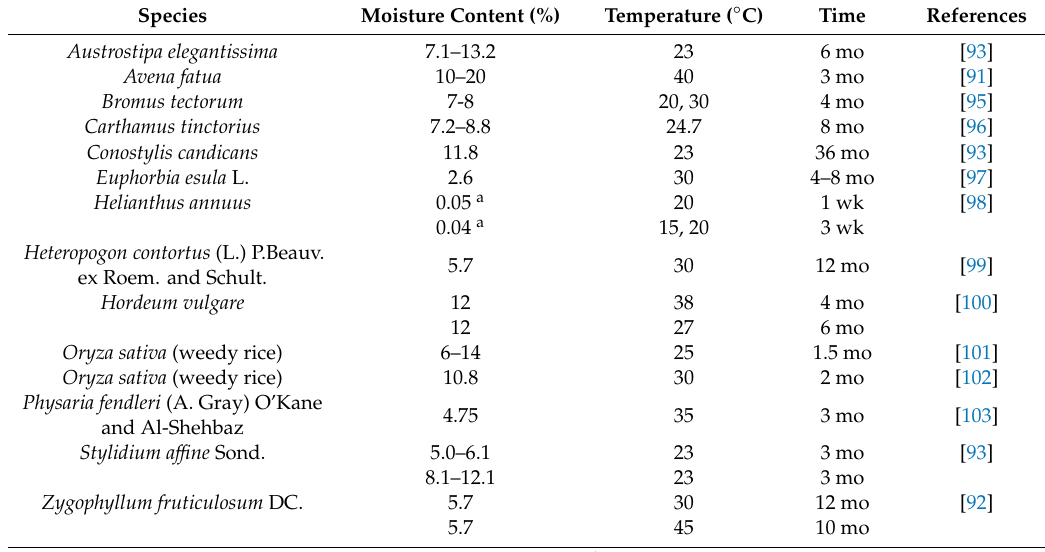
Table 1. The most e ff ective conditions for afterripening of seeds of various species. Authorities are given only for species not mentioned in the